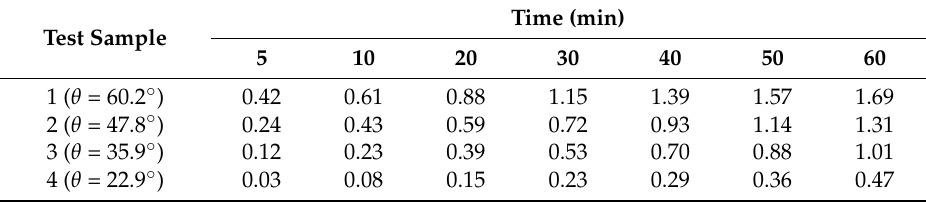
Table 6. The frost thickness of the different samples at T s = − 15 ◦ C, T a = 5 ◦ C, and ϕ = 60%. Test